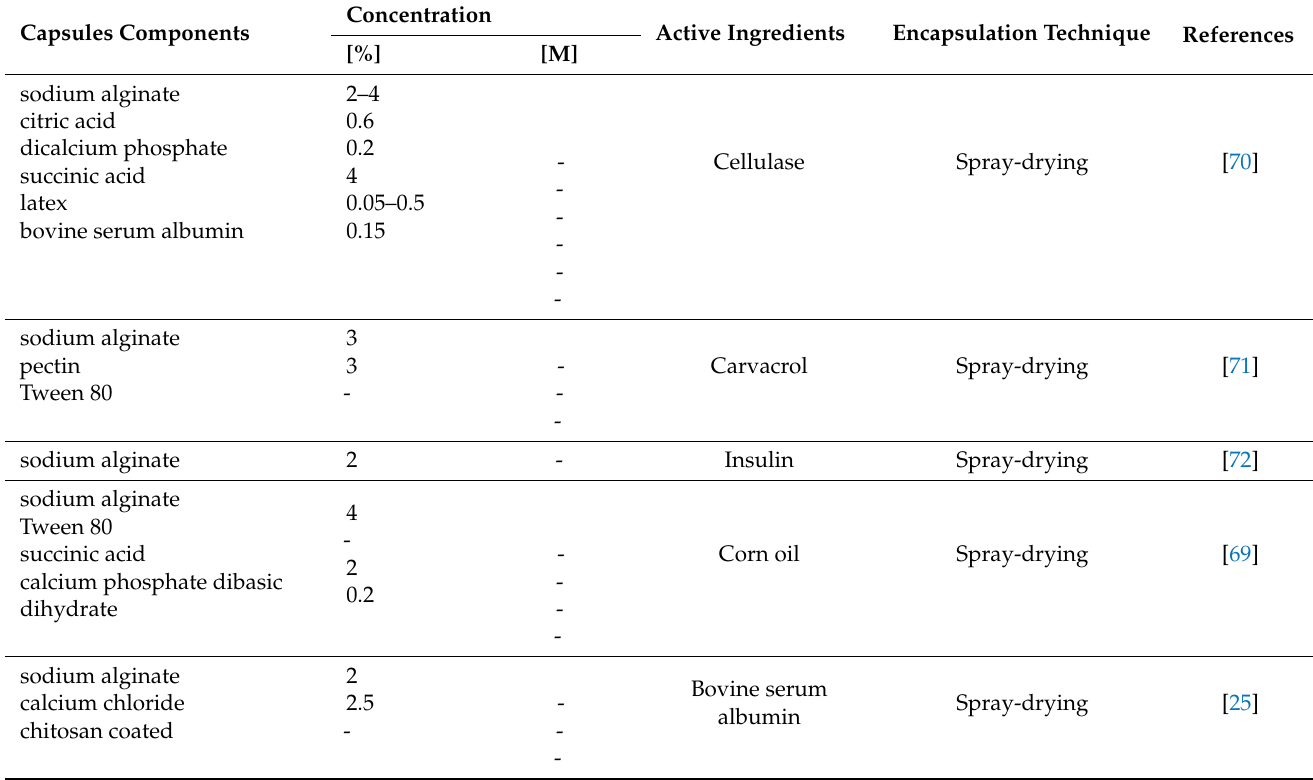
Table 4. The application of alginate carriers in the pharmaceutical